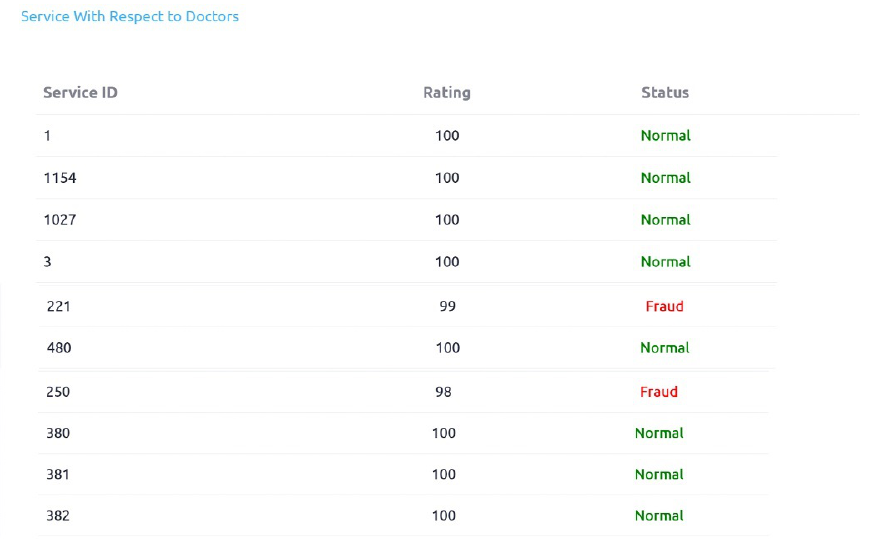
Figure 20. Service wrt doctors Rating and